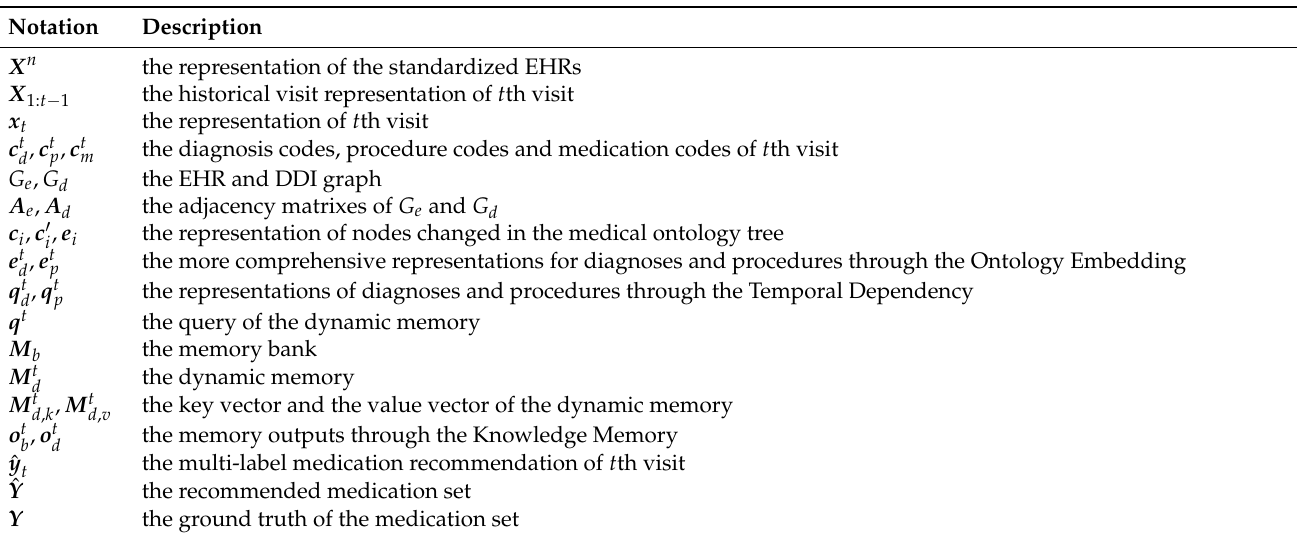
Table 1. Notations used in Med-tree.